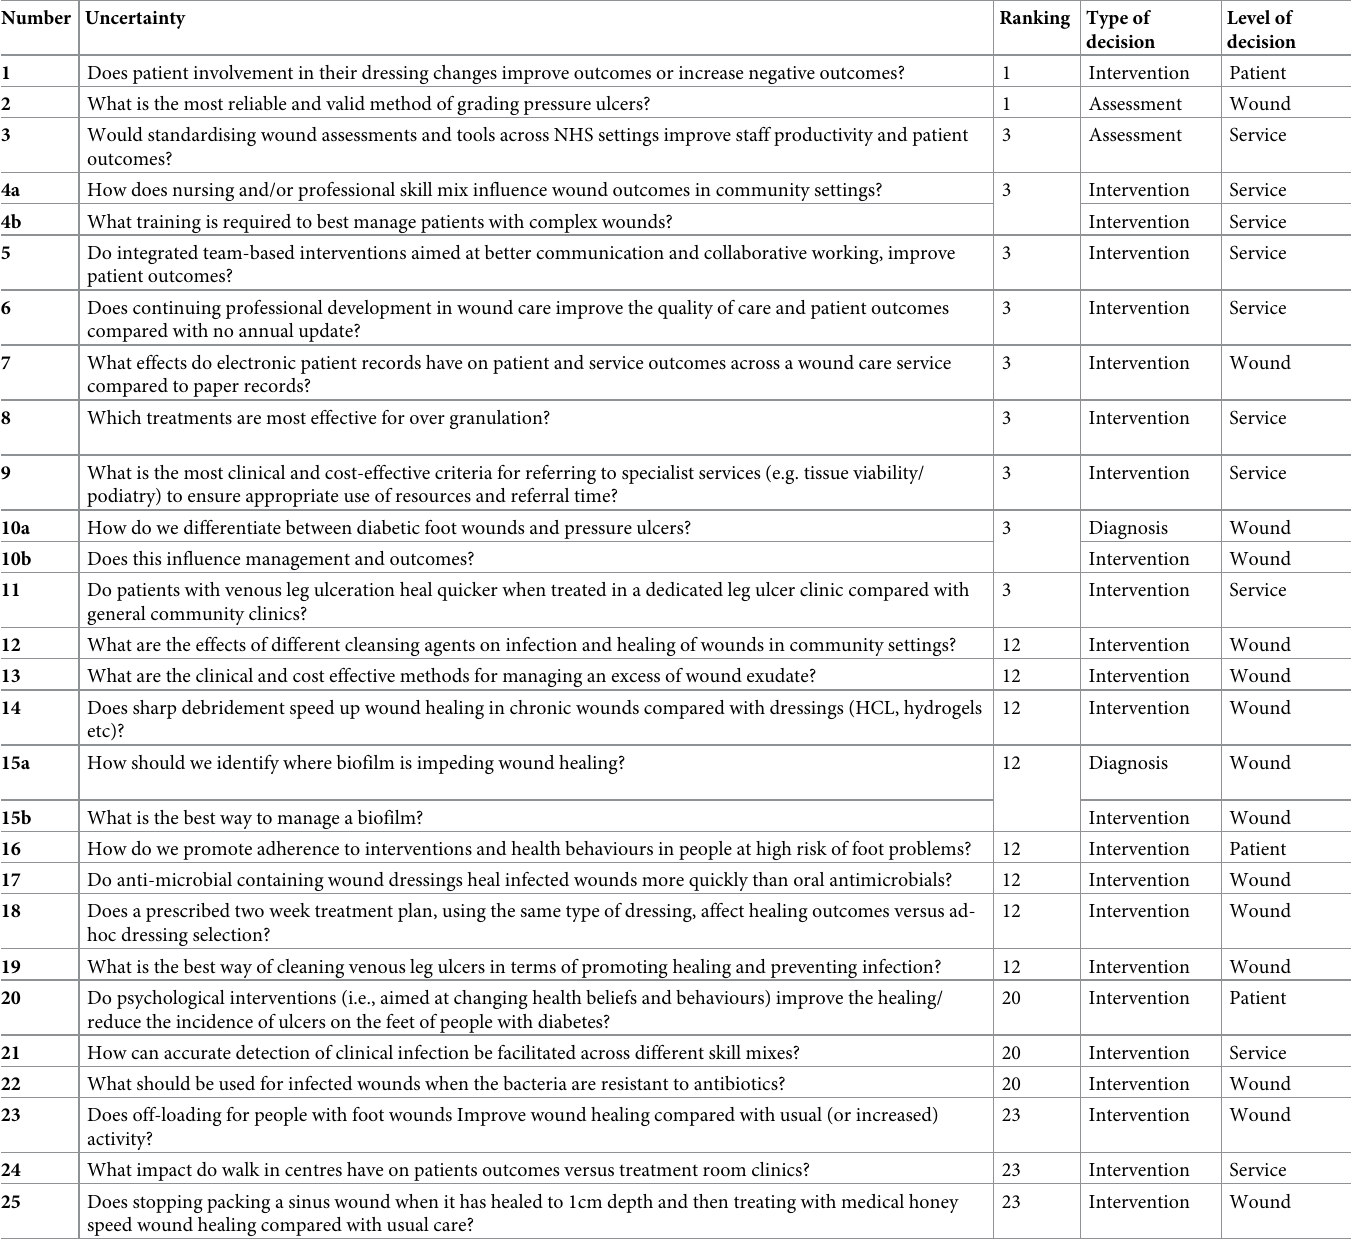
Table 2. Classification of healthcare professionals’